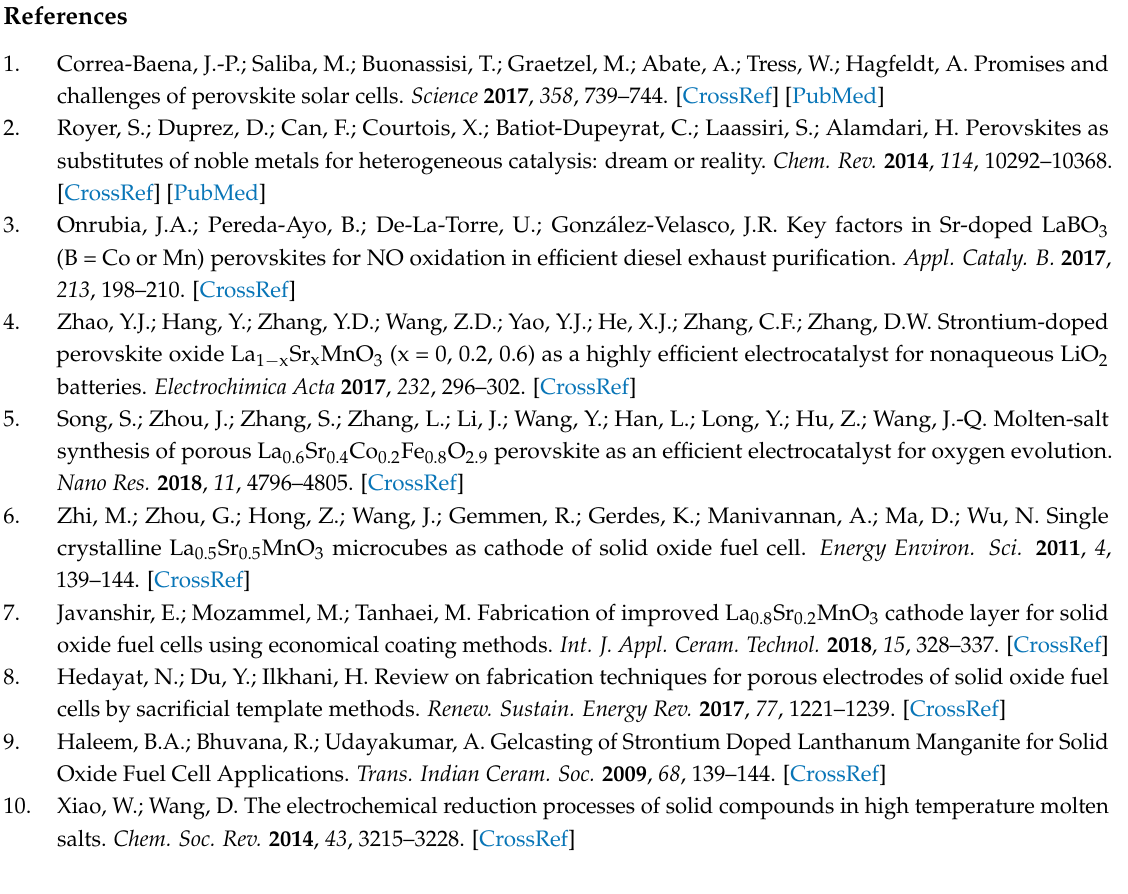
Figure S1: The TG curve of the LSM dehydrated body; Figure S2: Pores size distribution of LSM sintered bodies with different sintering temperatures; Figure S3: A diagram of LSM sintered bodies with different sintering temperatures; Table S1: The average pore diameter of sintered at different